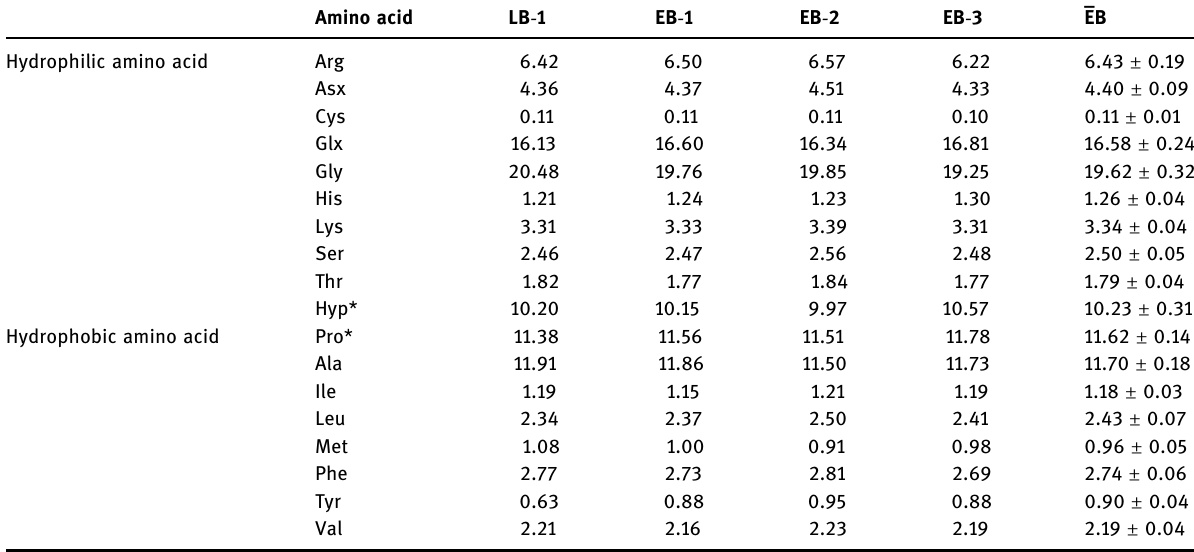
Table 3: Amino acid compositions of enzymatic and alkaline gelatin ( g/100 g